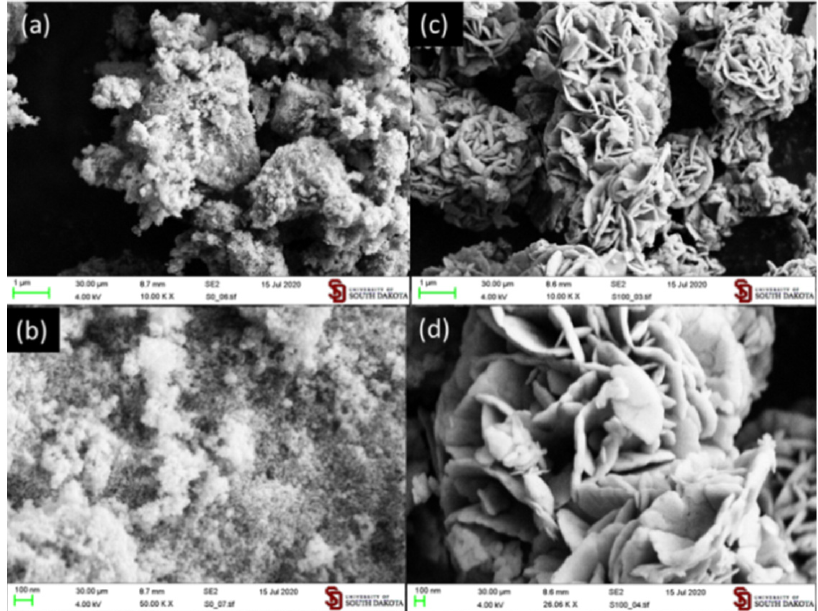
Figure 2. SEM images for ( a , b ): pristine TiO 2 (ST-0), and ( c , d ): SnS 2 (ST-100) nanomaterials. SEM images of different wt. % of SnS 2 . embedded TiO 2 nanocomposites, ST-5 (e), ST-10 (f), ST-15 (g), and ST-20 (h), are shown in Figure 3. These SnS 2 /TiO 2 nanocomposites in different wt. % possess nanosheets with a morphology decorated with sponge-like material and, therefore, exhibit aggregation.